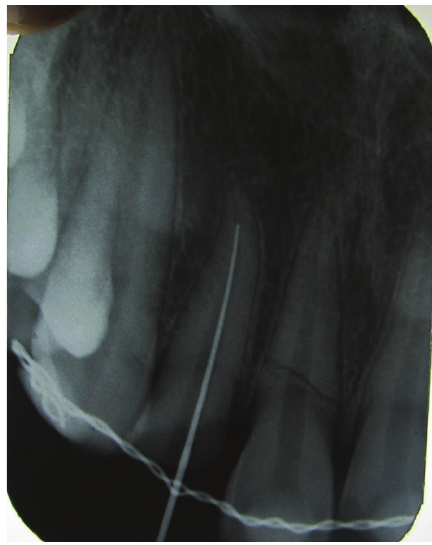
Figure 6: Obturation 12.